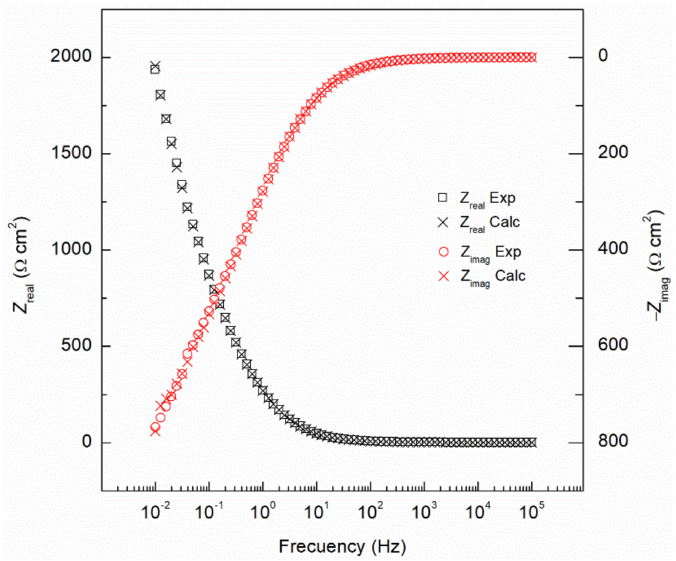
Figure 6. Kramers-Kronig (KK) transforms of Annealed CS rebar exposed to FA pore solution containing 0.6 M